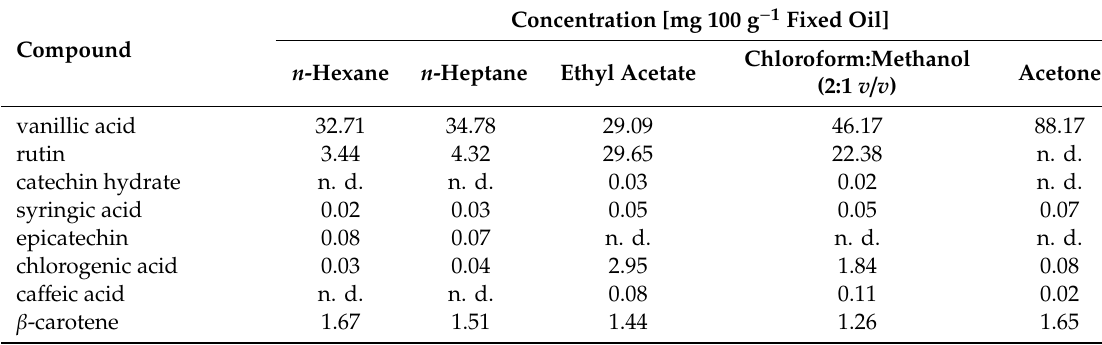
Table 4. The contents of phenolic compounds and β -carotene in plum seed oil.